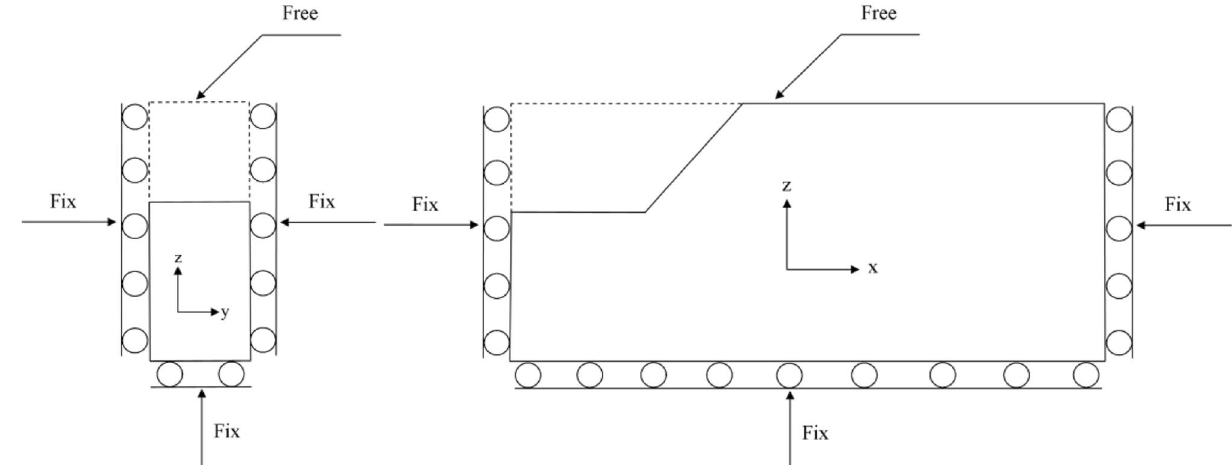
Fig. 1 Boundary conditions in different directions of x , y , and z